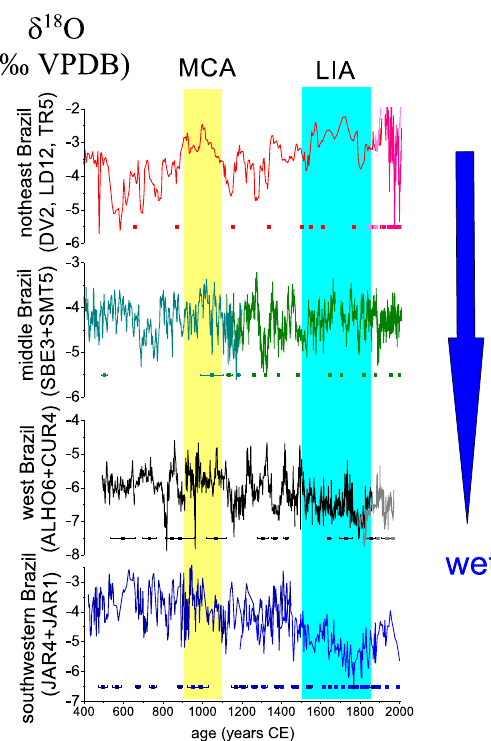
Figure 8. Holocene speleothem δ 18 O time series for the last 2kyrs: northeast Brazil (DV2 stalagmite–Diva Cave, TR5 stalagmite–Torrinha Cave, LD12–Lapa Doce); middle Brazil (SBE3 stalagmite–São Bernardo Cave, SMT5 stalagmite–São Matheus Cave); middle Brazil (ALHO6 stalagmite–Pau d’Alho Cave, CUR4–Curupira Cave), and southwestern Brazil (JAR4 and JAR1 stalagmites–Jaraguá Cave). The yellow and blue shading indicates the Little Ice Age (LIA) and the Medieval Climate Anomaly (MCA). Figure modified from reference [22]. CE is Common Era.